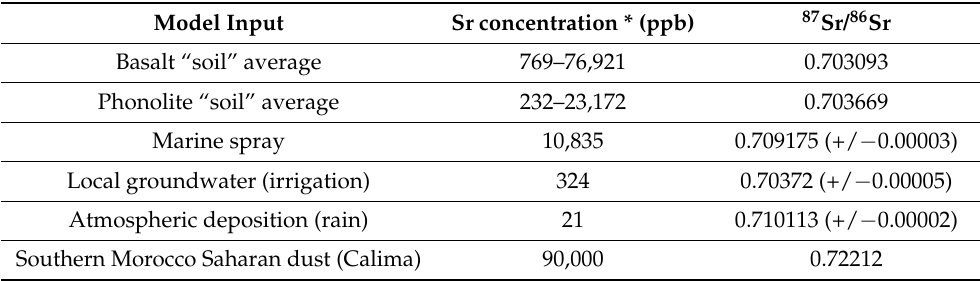
Table 4. Natural inputs to the Tenerife viticulture system. Substratum rocks are 12–1200 times more enriched in Sr than their derivative soils [23]. These two endmembers constrain a soil composition based on the average basalt and phonolite compositions of Tenerife (basalt n = 110; phonolite n = 39 [28]). Average marine spray ( n = 4), average local groundwater ( n = 4) and rainfall samples ( n = 2) collected locally and measured at the ITER TIMS facility, (1SD absolute given); southern Morocco Saharan dust composition ( n = 8)